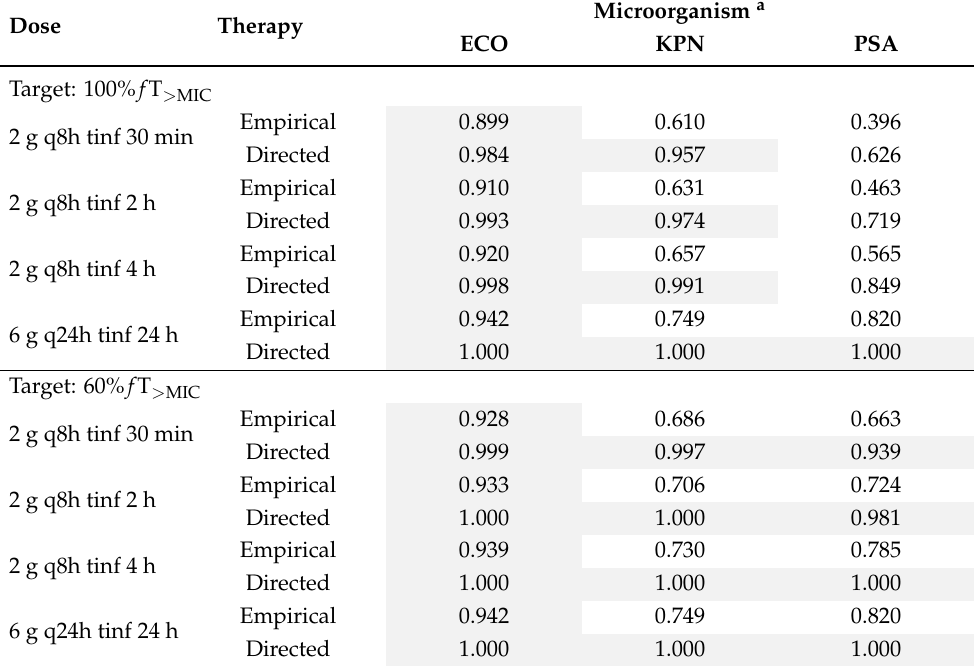
Figure 3. Probability of target attainment (PTA) versus MIC for different estimates of creatinine level, each derived from 2500 simulations of data (PTA was evaluated at steady state). The gray lines demonstrate PTA in various scenarios of creatinine level. The dotted black lines represent a PTA of 0.90. Table 3. Comparison of CFR for cefepime in empirical and directed therapy for three microorganisms. The gray color in a cell indicates a CFR ≥